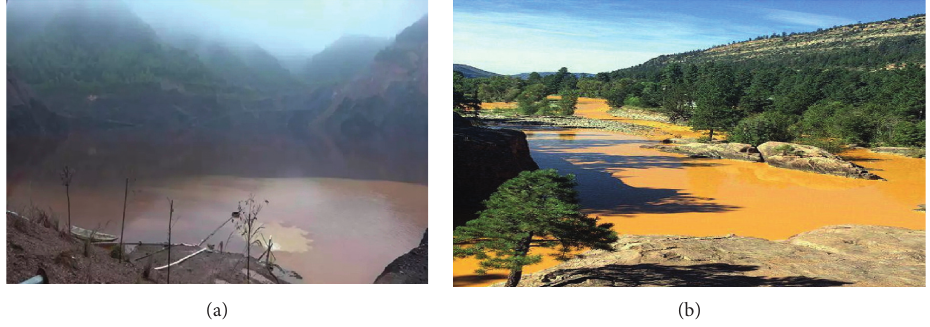
Figure 1: Schematic diagram of mine water pollution. (a) Acid mine wastewater. (b) Excessive heavy metal mine